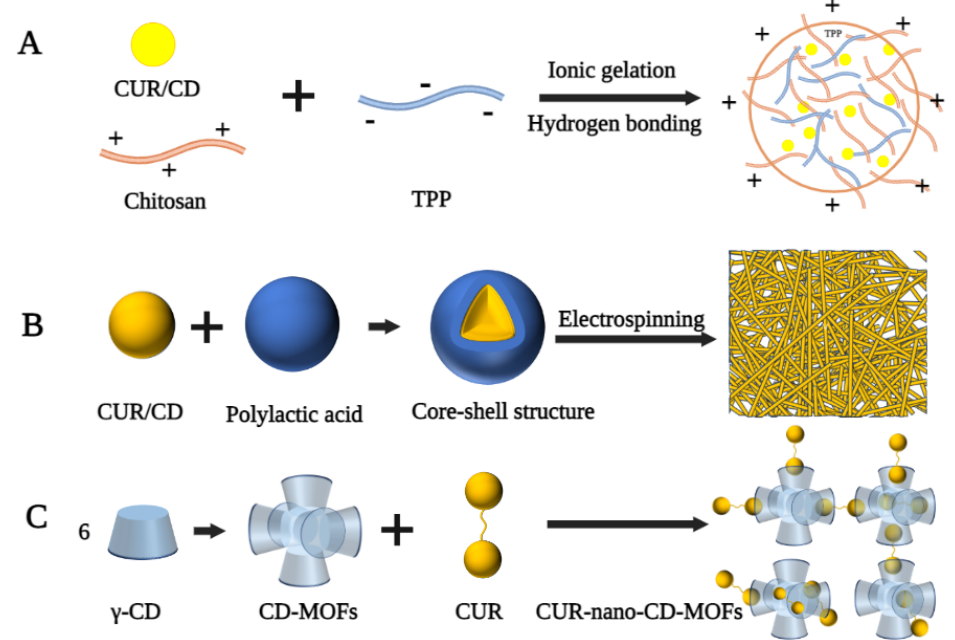
Figure 4. Fabrication process of different types of curcumin-loaded CD-based nanocarriers. ( A ) Chitosan-based nanoparticles [85]. ( B ) Nanofiber [88]. ( C ) Cyclodextrin-based metal–organic framework nanoparticles [89].